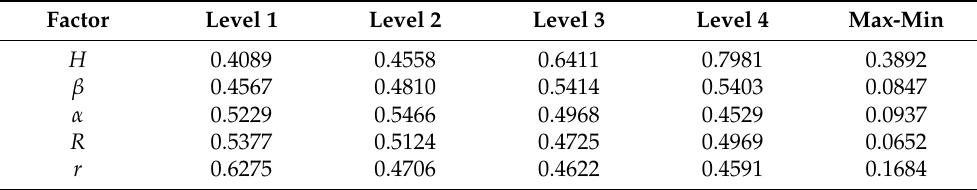
Table 8. Average